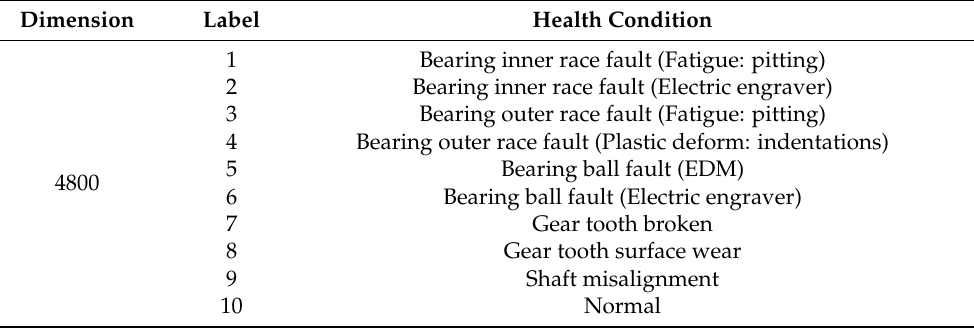
Table 7. Health status data on the experimental